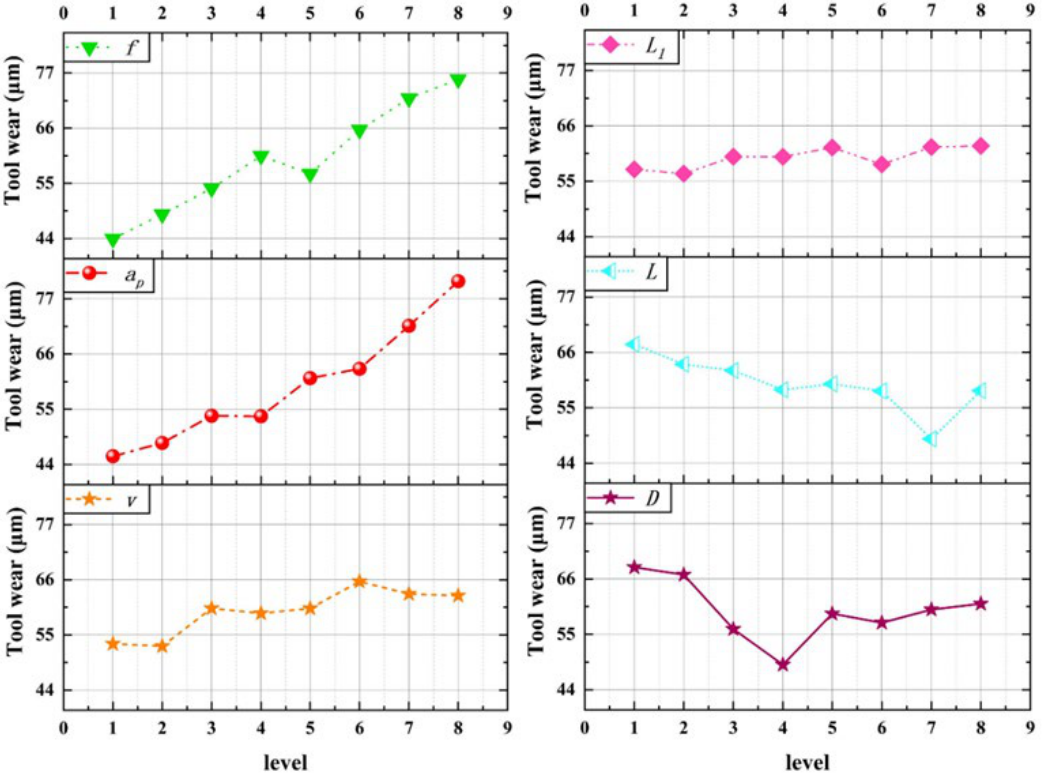
Figure 11. Tool wear range analysis results.